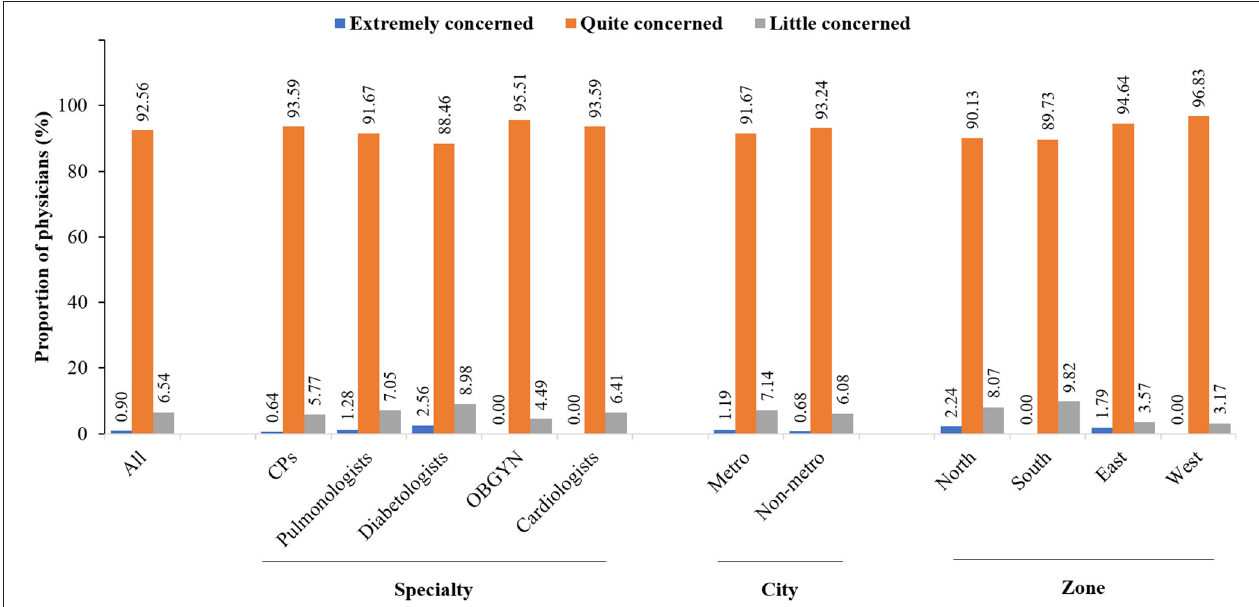
FIGURE 2 | Overall attitude of physicians. CPs, consulting physician; OBGYN, obstetricians and gynecologists.